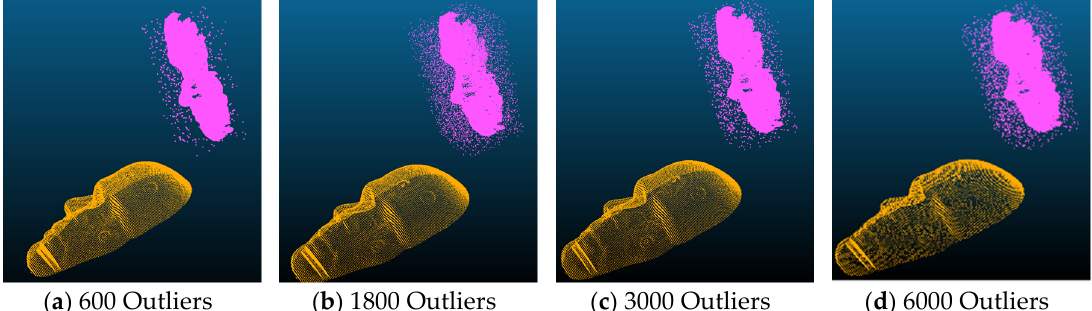
Figure 6. Examples of floating (pink) with Gaussian noises and reference points (gold) used in the experiments. Table 5. The Average, Minimum and Maximum of Reference Points’ Alignment Errors .